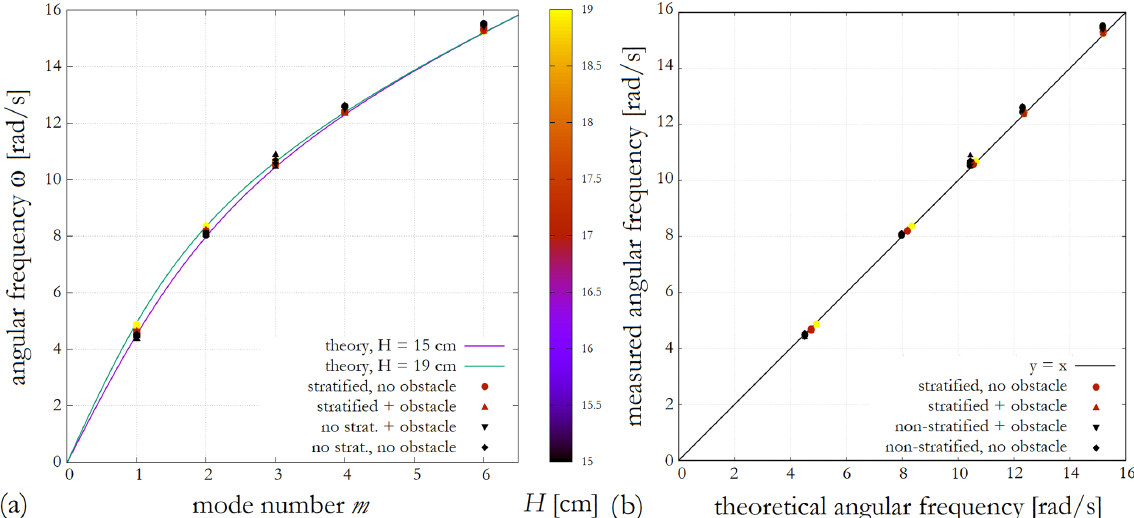
Figure 6. (a) The dispersion relation of water surface waves (Eq. (2)) expressed as a function of the dominant mode index m . The solid curves represent the theoretical relationship for the shallowest ( H = 15cm) and deepest ( H = 19cm) configurations and the data points indicate the measured values of angular frequency ω . The coloring is based on the total water height H . (b) Contrasting the calculated angular frequency ω from Eq. (2) to its measured value. The various experiment configurations are indicated by the shapes of the symbols in both panels (see